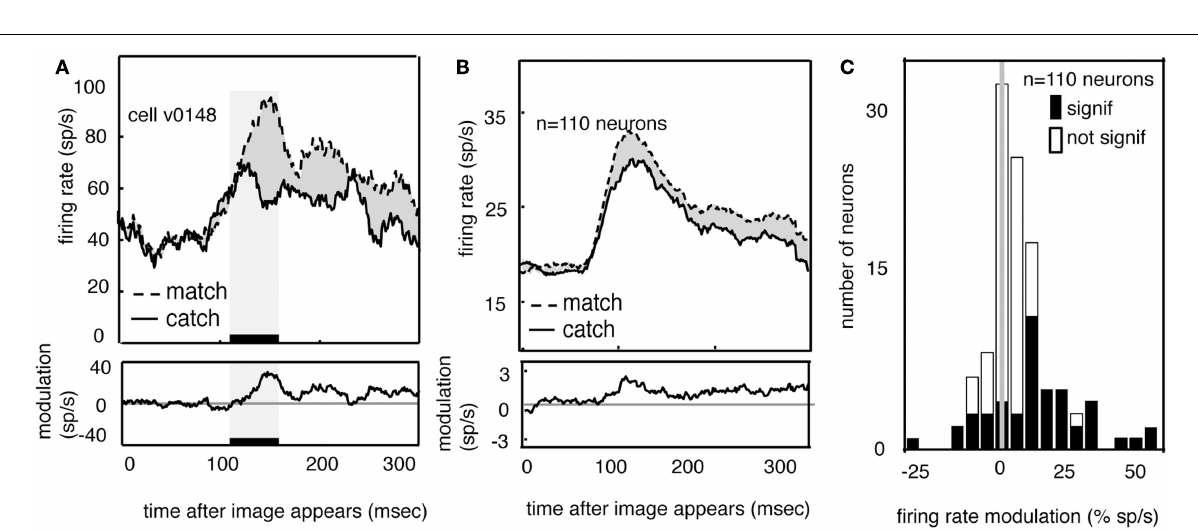
FIGURE 5 | Neural responses to images are enhanced when the appear in the match context. (A) Average response of a typical neuron to matches and feature catches, and their difference. Responses are enhanced when the stimulus matches the one held in memory.This enhancement appears during the early portion of the response (black bar beneath curve). (B) Average response of all neurons in our sample ( n = 110) in match and catch conditions, and their difference. Across the